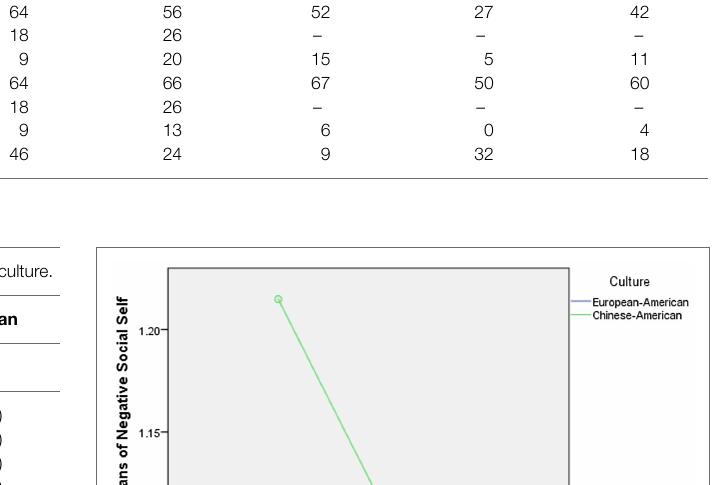
Emotion terms: Negative